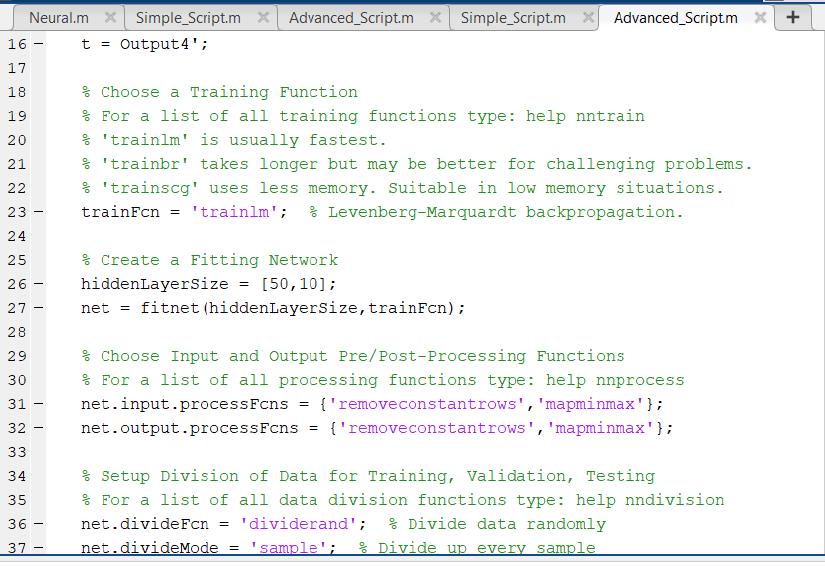
Figure 9. Different activation functions. After running the new code, a neural network structure that has new activation func- tions for the first hidden layer will be created as shown in Figure 10. Table 5 shows the new artificial neural network features. Figure 10. New neural network structure with activation function. Table 5. New artificial neural network features. Inputs